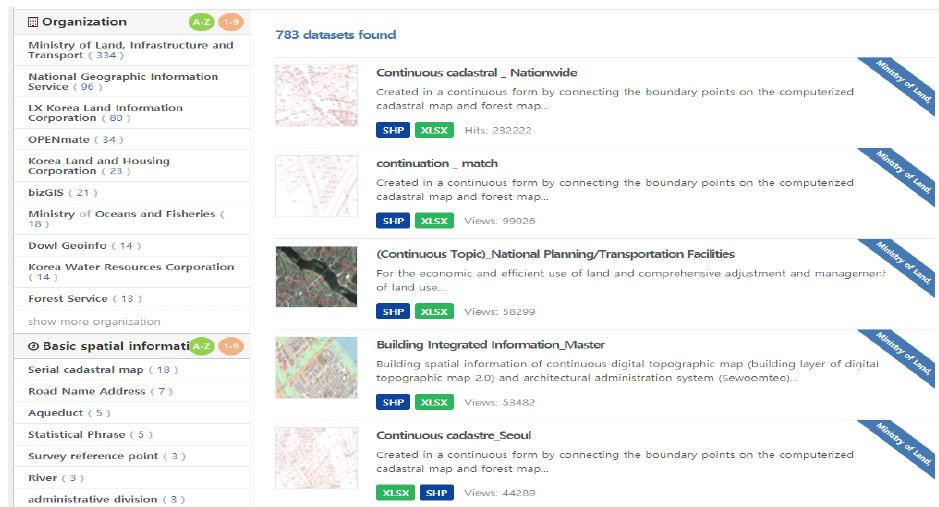
Figure 5. Spatial dataset provided by ‘Open market’.